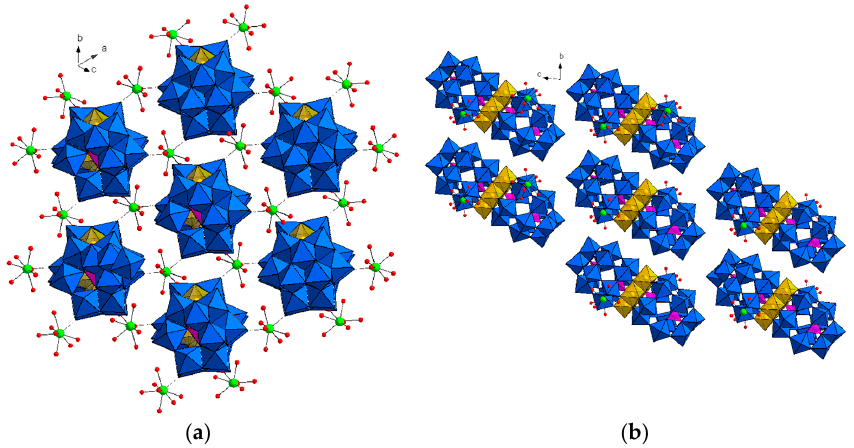
Figure 3. ( a ) The two-dimensional (2D) network packing arrangement in Dy 2 Mn 4 -P 2 W 15 ; ( b ) packing of Dy 2 Mn 4 -P 2 W 15 viewed down the a-axis. Crystal water molecules and sodium cations are omitted for clarity. Color scheme: Dy = green; O = red; WO 6 octahedron = blue, MnO 6 octahedron = gold; PO 4 tetrahedron = Pink.